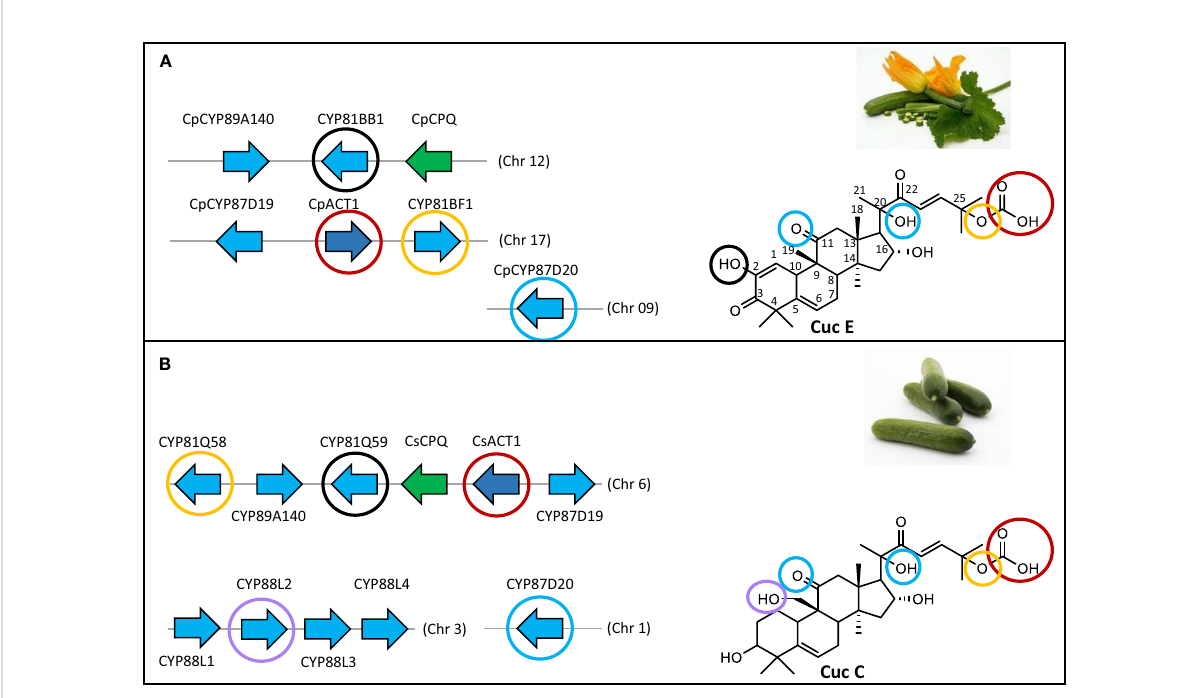
FIGURE 2 The main cucurbitacin biosynthetic cluster in Cucurbita pepo is split in two chromosomes. (A) Chromosomal organization of cucurbitacin biosynthetic genes in C. pepo . Modi fi cations on the cucurbitadienol backbone performed by each gene are highlighted in distinct colored circles. (B) Chromosomal organization of cucurbitacin biosynthetic genes in Cucumis sativus . Modi fi cations on the cucurbitadienol backbone performed by each gene are highlighted in distinct colored circles. CYP81Q58 catalyzes the C25 hydroxylation; CYP81Q59 the C2 hydroxylation; CpCPQ the fi rst committed step in cucurbitacin biosynthesis making cucurbitadienol backbone; ACT1 transfer an acetyl group to the C25 hydroxyl, CYP87D20 is a C11 carboxylase and hydroxylates the C20 position, CYP88L2 hydroxylates the C19